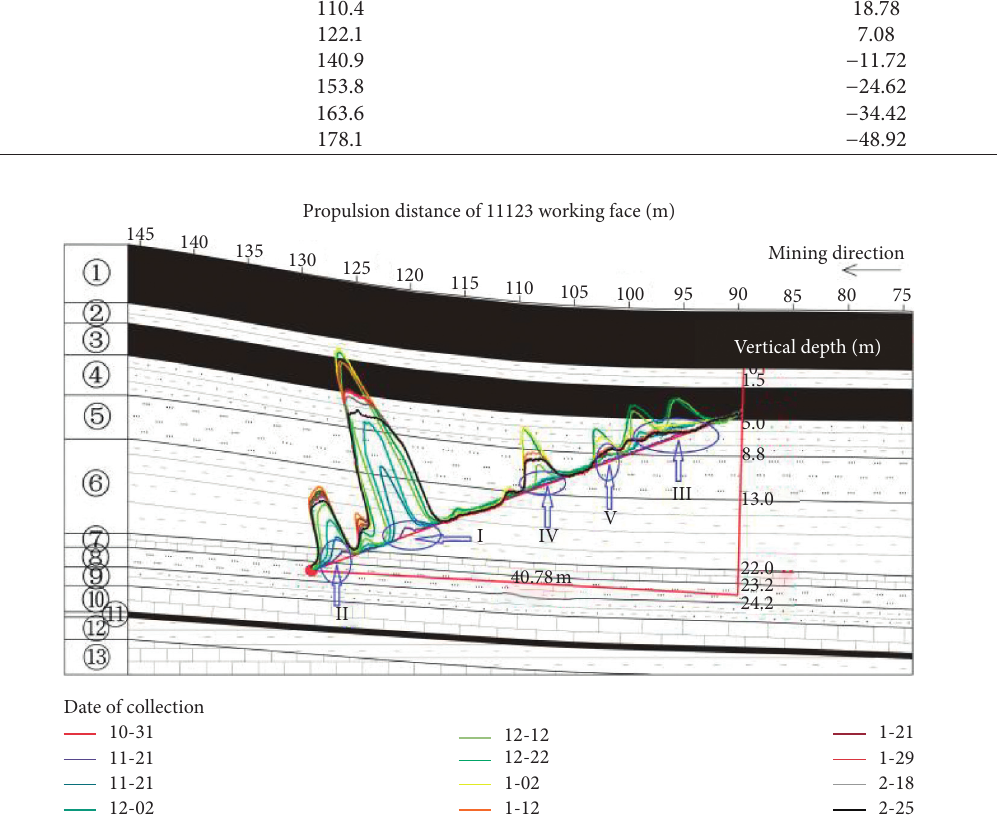
Figure 5: Corresponding relationship between strain distribution of the optical fibers and the stratum.